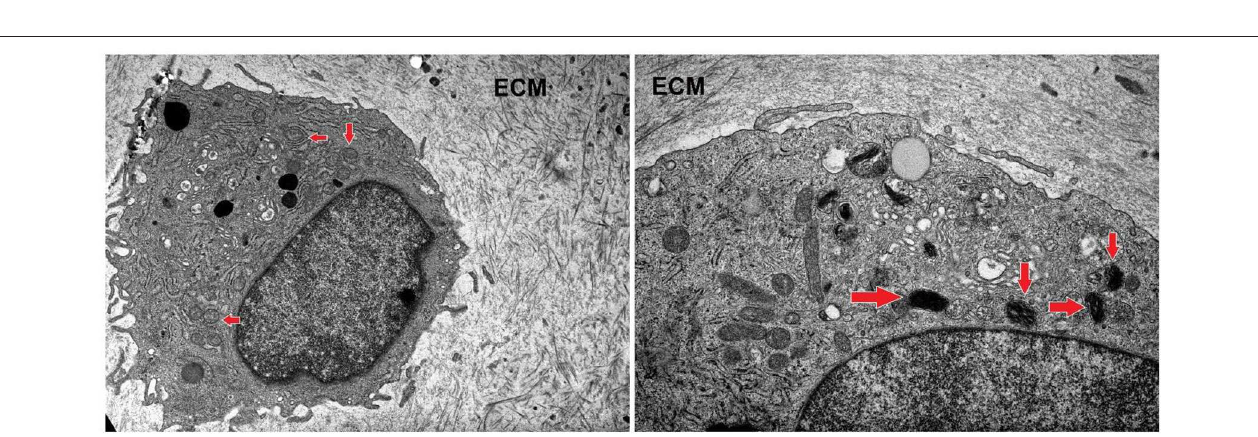
FIGURE 7 | Sections of cartilage explants derived from cartilage samples, untreated (control), and treated with nifedipine (10 µ M). Control sample –unchanged chondrocyte in ECM, with normal, light mitochondria (marked by arrows). Magnification × 4k. nifedipine-treated sample—matrix of some mitochondria is darker (marked by arrows). Magnification × 10k. ECM, extracellular